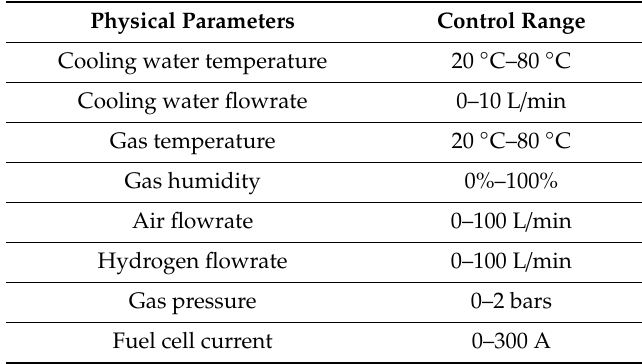
Figure 1. Proton exchange membrane fuel cell (PEMFC) test bench provided by the 2014 IEEE Fuel Cell Data Challenge Competition [20]. Table 1. Control range of experimental physical parameters provided by the 2014 IEEE Fuel Cell Data Challenge Competition [20].